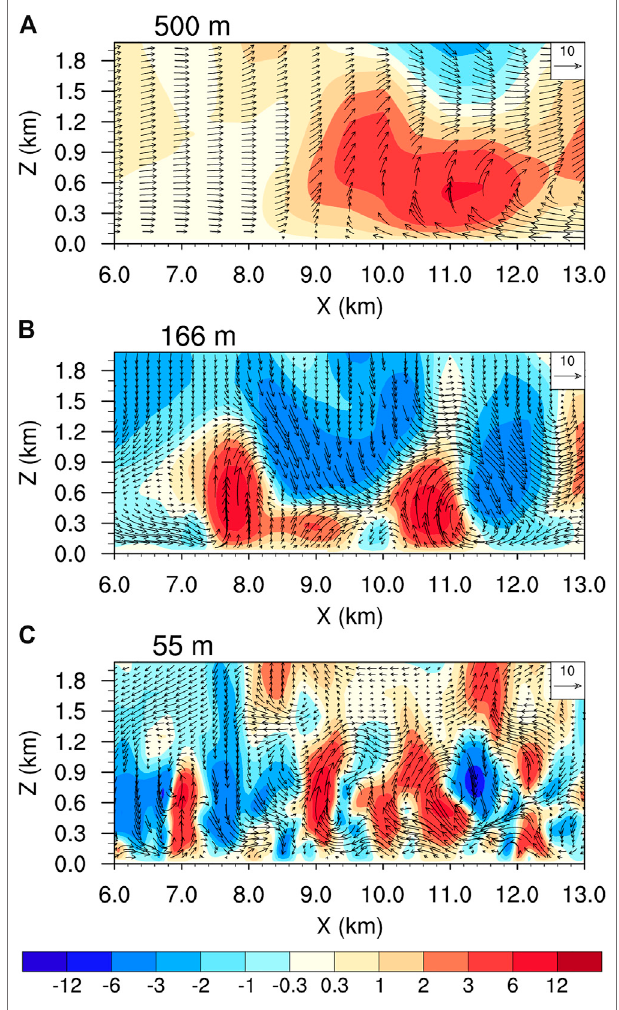
FIGURE 7 | Vertical cross sections of vertical velocity (shaded, m s − 1 ) and the perturbation horizontal winds (vectors, m s − 1 ) from the grid spacings of (A) 500 m, (B) 166 m and (C) 55 m along the line segments shown in Figures 6A – C . Note that the perturbation horizontal winds are de fi ned as the difference in vector winds between the instantaneous horizontal winds and the horizontal winds after an average in the 8 km by 8 km box.